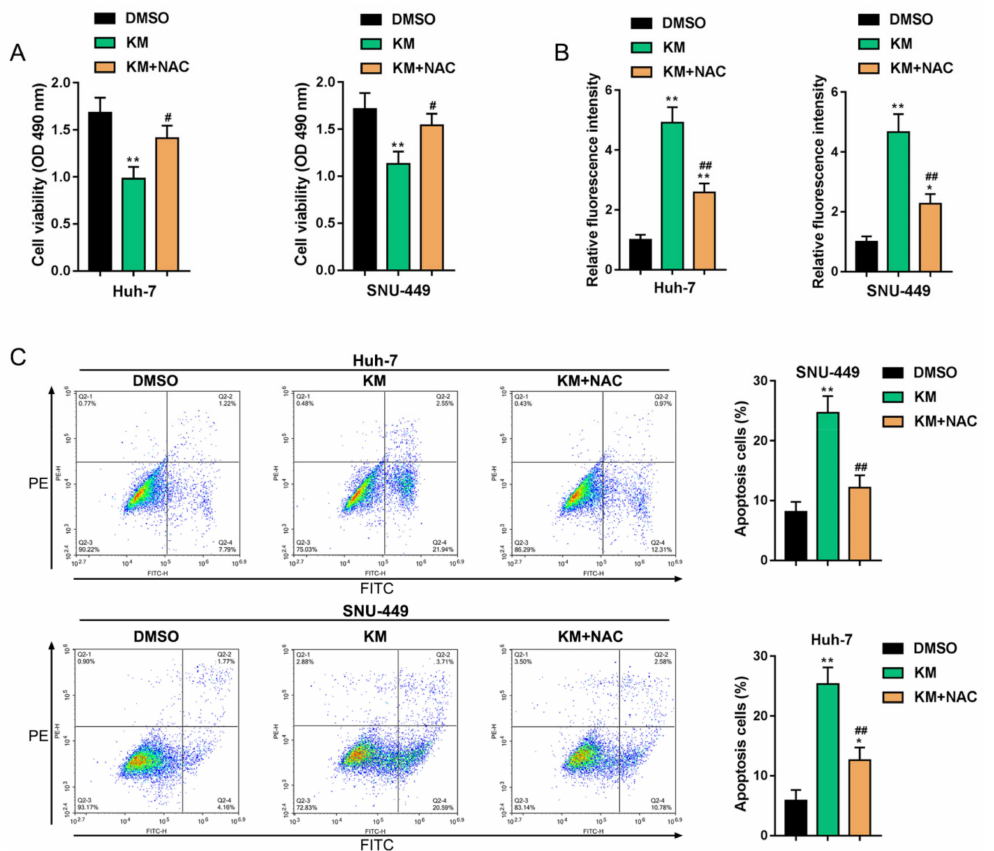
Figure 4. Koumine a ff ects HCC cell behaviors through producing excess ROS. HCC cells were co-treated with 400 µ g / mL koumine and 800 µ M N-acetylcysteine (NAC) and examined for ( A ) cell viability by MTT assay; ( B ) the production of ROS by DCFH-DA assay; ( C ) cell apoptosis by flow cytometry. * p < 0.05 and ** p < 0.01 vs. DMSO control group, # p < 0.05 and ## p < 0.01 vs. KM group.